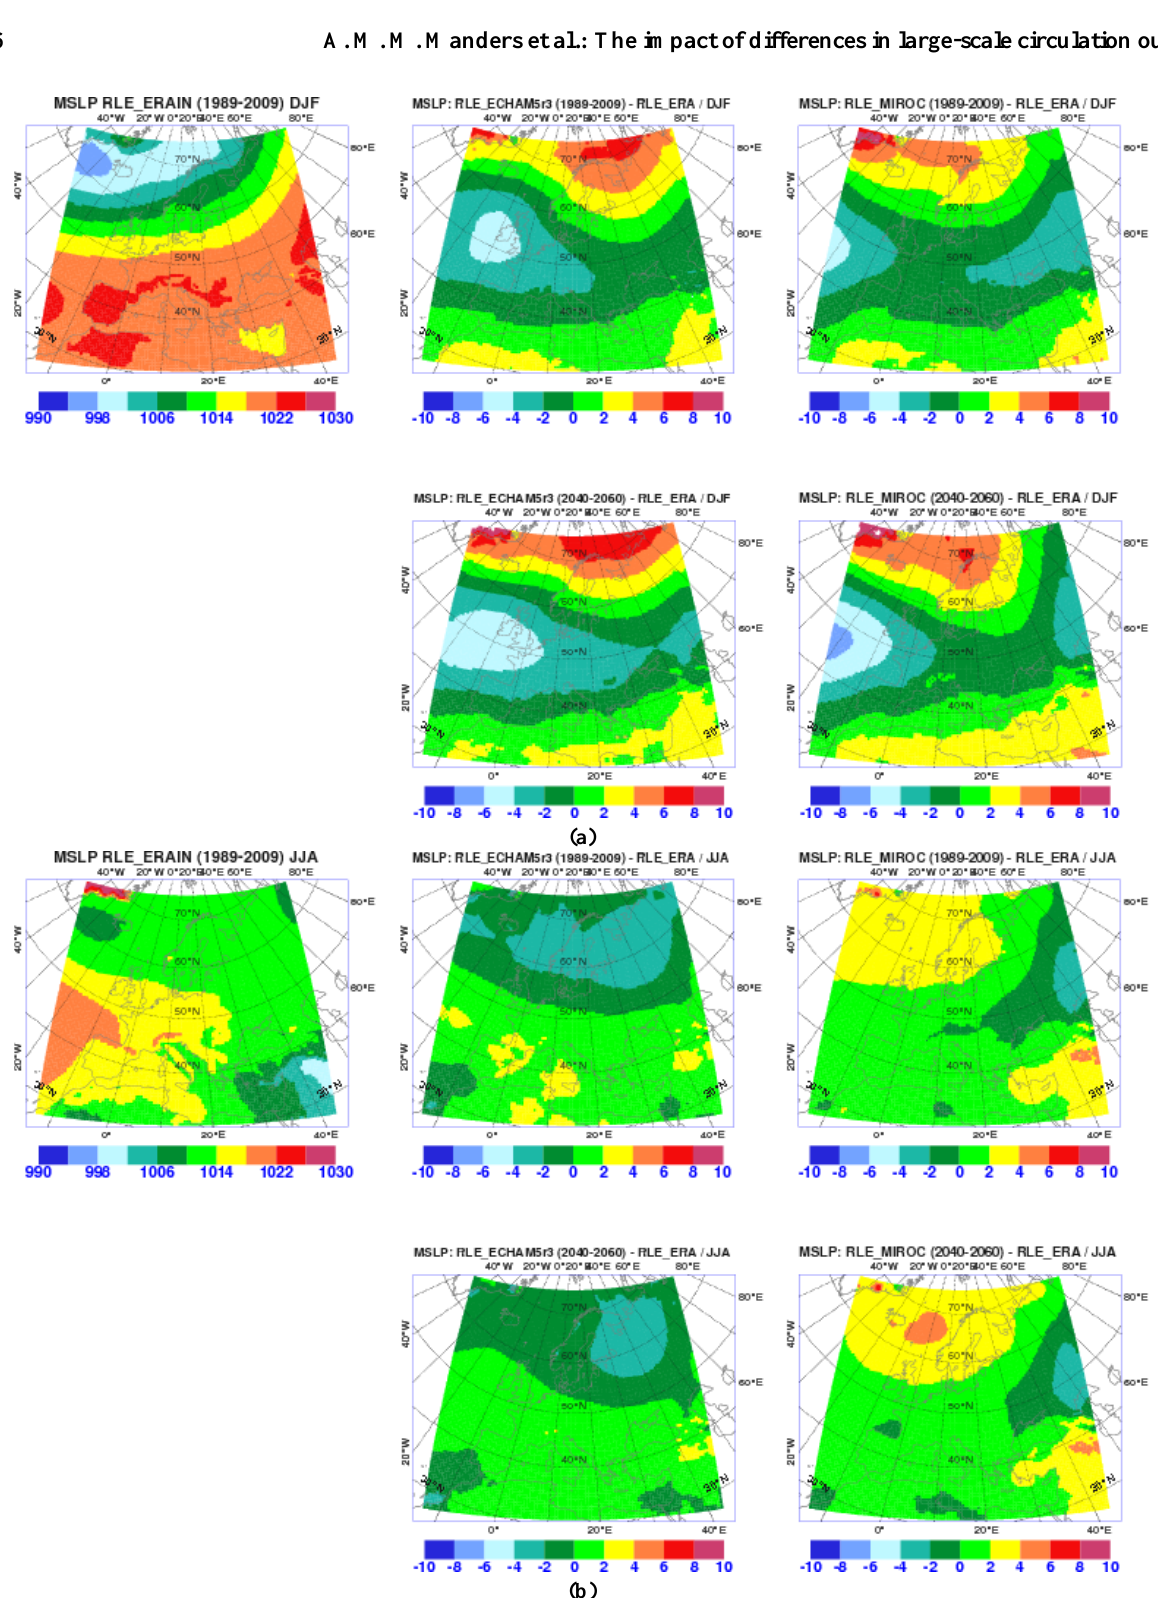
Fig. 2. (a) Top-left panel: average winter (December-January-February) mean sea level pressure (hPa) from RLE ERA. Central (right-hand) panel: differences in mslp between RLE ECHAM5 (RLE MIROC) and RLE ERA for the present-day climate (1989–2009, top row) and the future climate (2040–2060, bottom row). (b) Like (a) but for summer